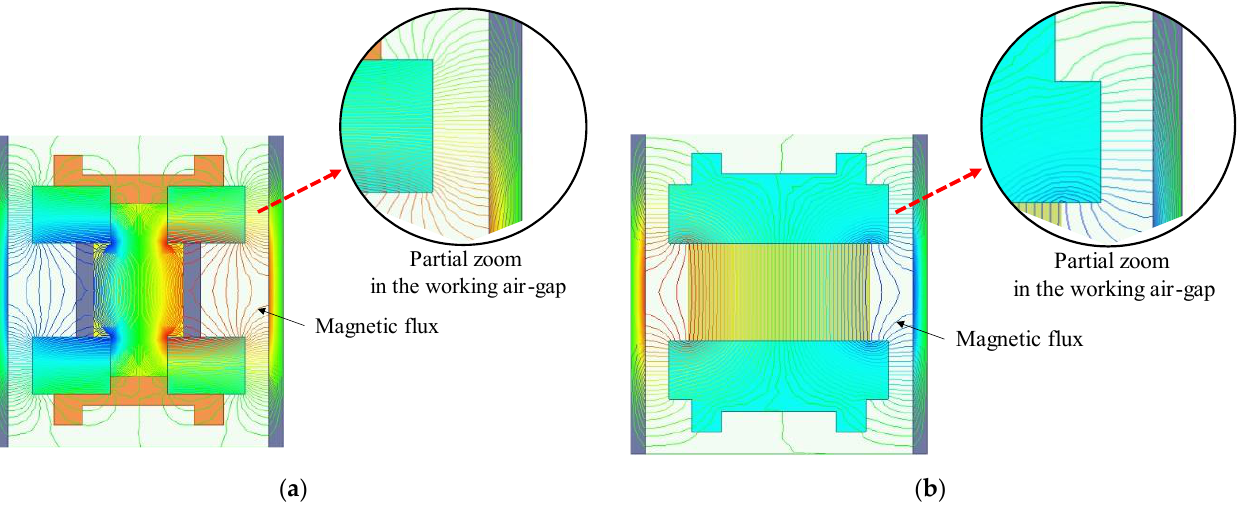
Figure 12. Comparison of the magnetic flux distribution of the working air-gap for the two mag- netic field structures. ( a ) DM structure; ( b ) conventional structure. The density of magnetic flux depicts the intensity of the magnetic field.